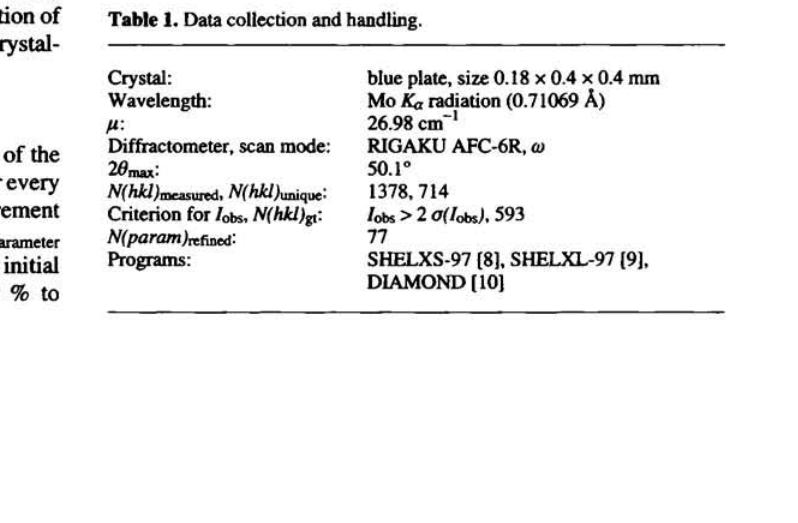
Table 1. Data collection and